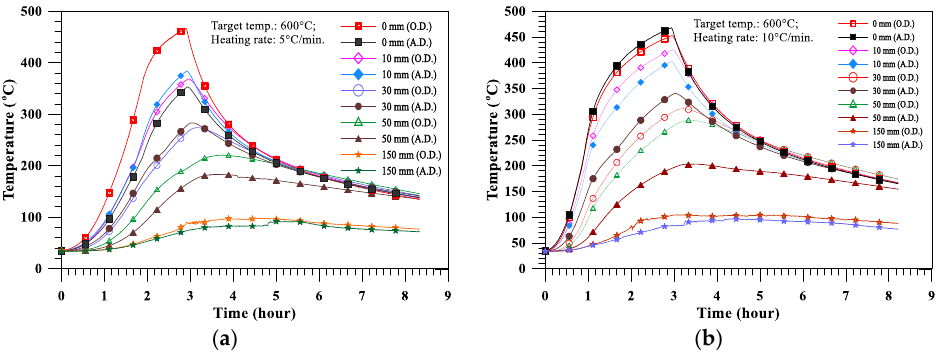
Figure 7. Comparison of the temperature distributions of the LWAC specimens at a target temperature of 600 °C: ( a ) heating rate of 5 °C/min; ( b ) heating rate of 10 °C/min.